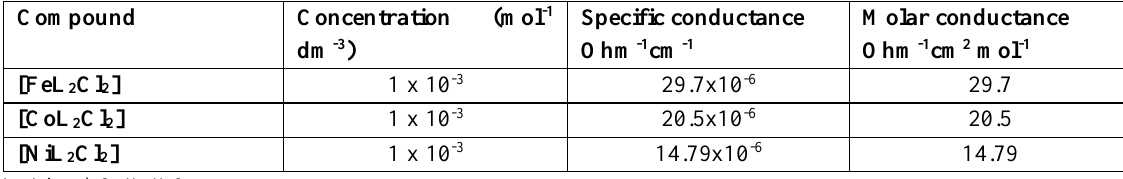
Table 5. Conductivity measurement of complexes in DMSO solution (1X10 3 moldm -3